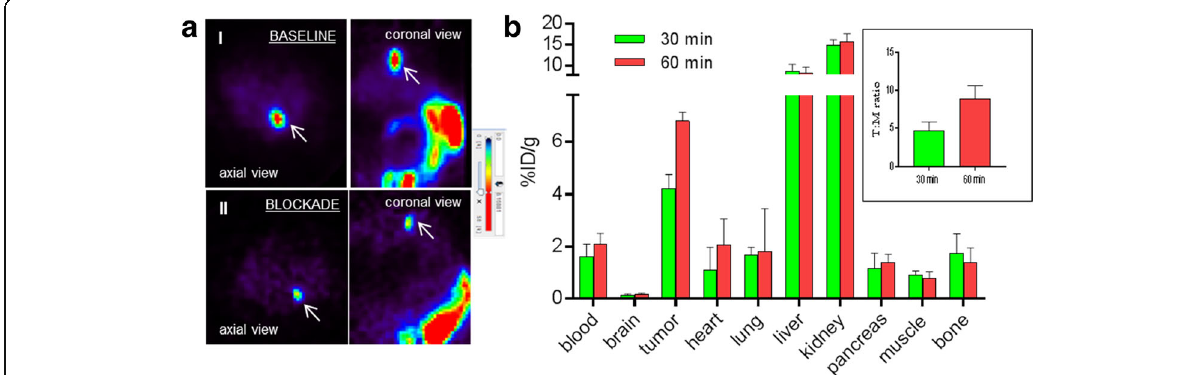
Fig. 5 a Representative microPET images of 18 F-KS1 in PC3-bearing mice ( n = 3): (I) baseline (II) blocking with KS1 in axial and coronal views, with arrow mark highlighting the tumor. b Standard biodistribution of 18 F-KS1 in PC3-bearing mice with values in %ID/g, p values ≤ 0.05 considered statistically significant ( n = 3), with tumor to muscle ratio highlighted